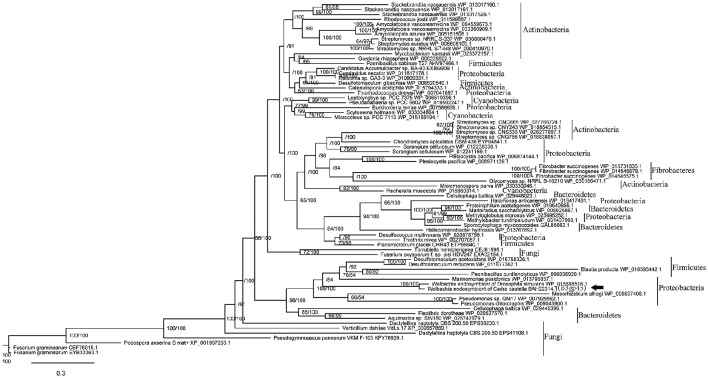
Phylogeny based on the amino acid sequences of phage WOcauB3 spvB gene B3gp45 and its homologs. Phylogeny based on alignment of 766 aa consisting of top E-value (<10−5) hits to blastp using WOcauB3 spvB gene as a query. There is an apparent transfer from unrelated genetic lineages of bacteria to Wolbachia, marked with arrowhead. Each tip is labeled with the species name and the sequence's Genbank accession number. Bootstrap values (maximum likelihood phylogeny) and posterior probability (bayesian phylogeny) higher than 50% are shown. The black box on the right represents the phyla.